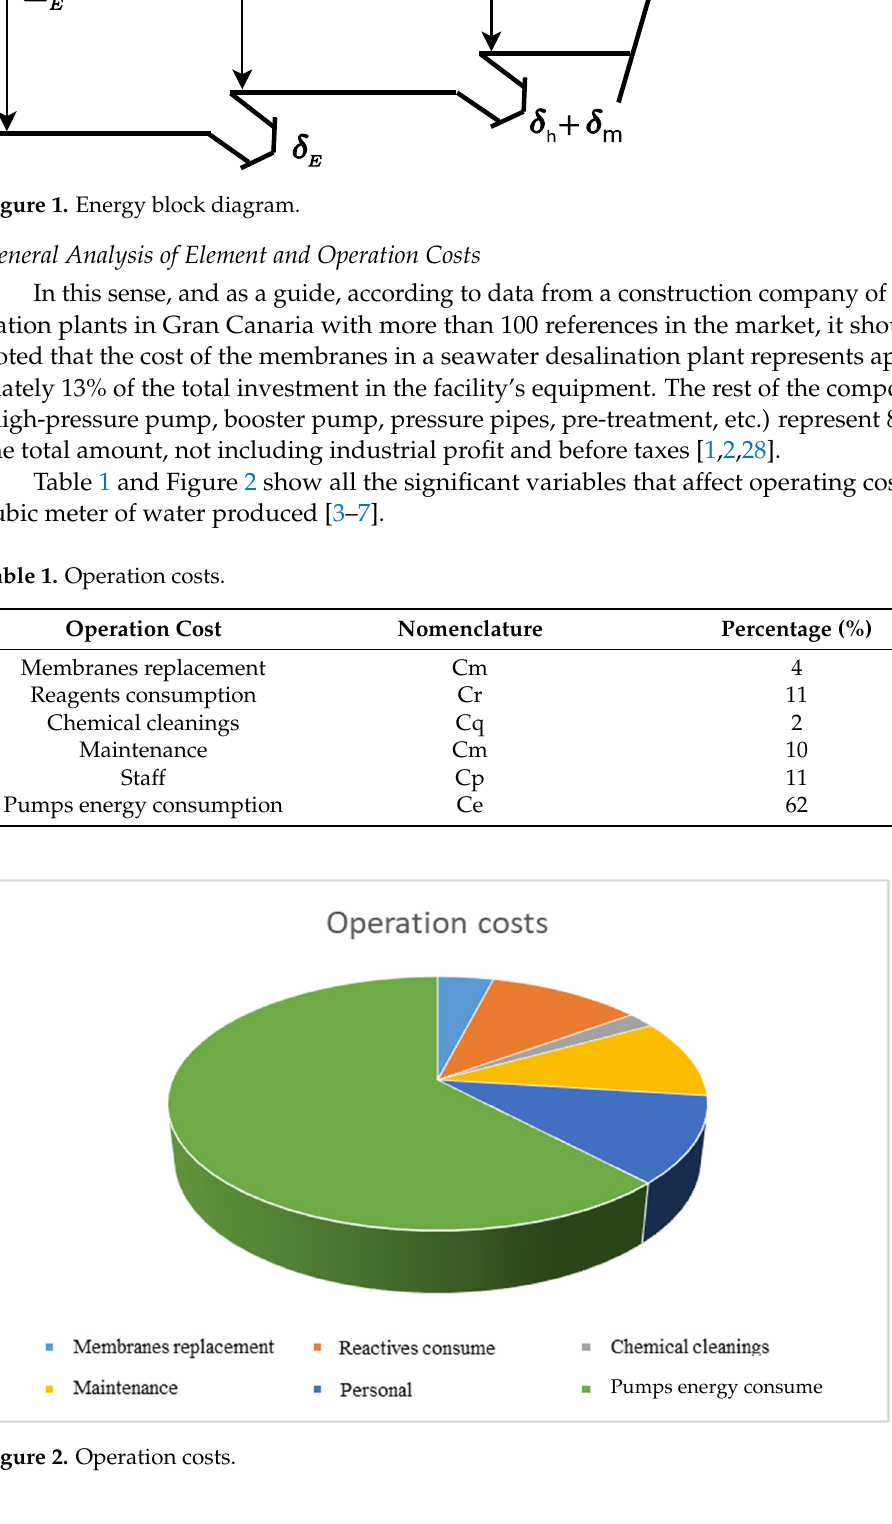
Figure 2. Operation costs.